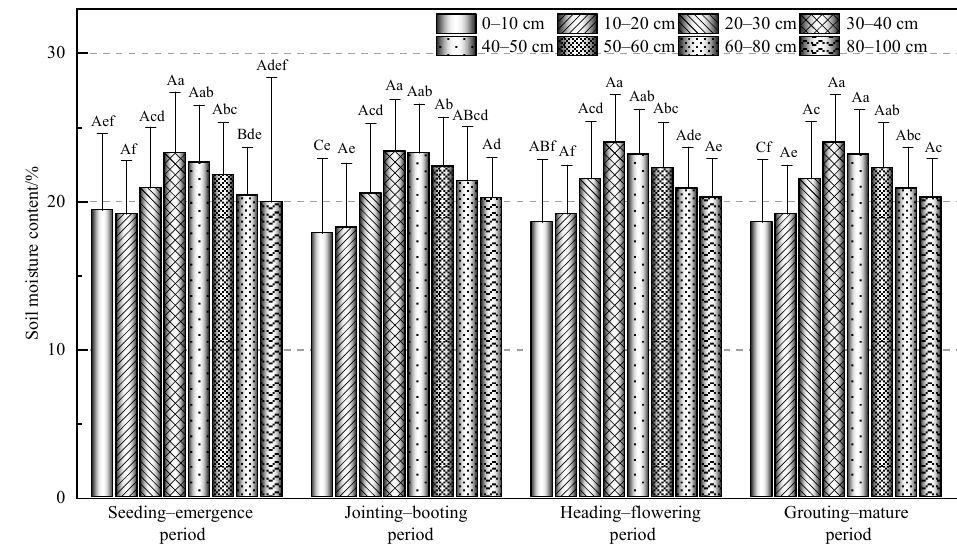
Figure 3. Effect of different growth periods of maize on soil moisture content.